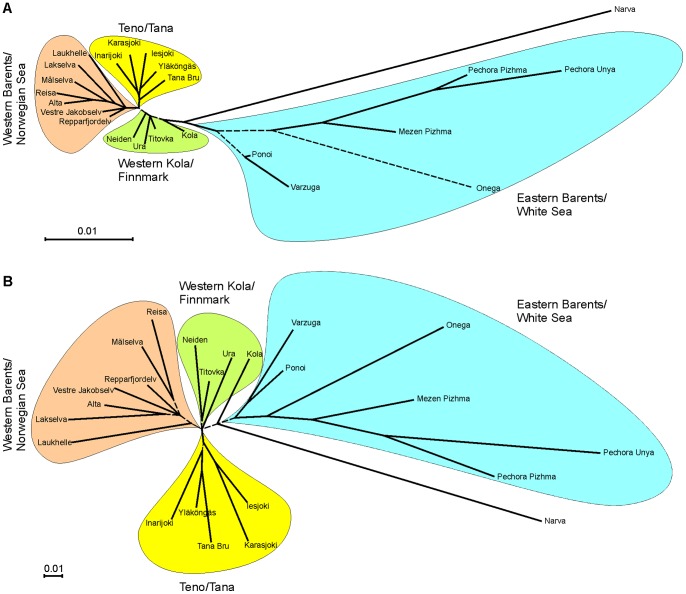
Genetic relationships among 23 Atlantic salmon populations in northern Europe.Neighbour-joining dendrogram is based on Nei’s D
A genetic distances estimated using (A) 2880 SNPs and (B) 31 STR markers. Distinct population groups are colored. The branches with bootstrap value support <80% are drawn as dashed.